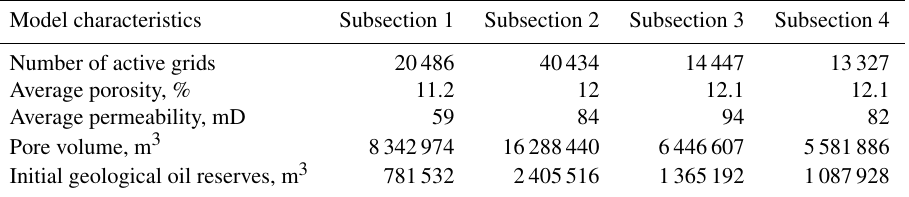
Table 1. Model characteristics.